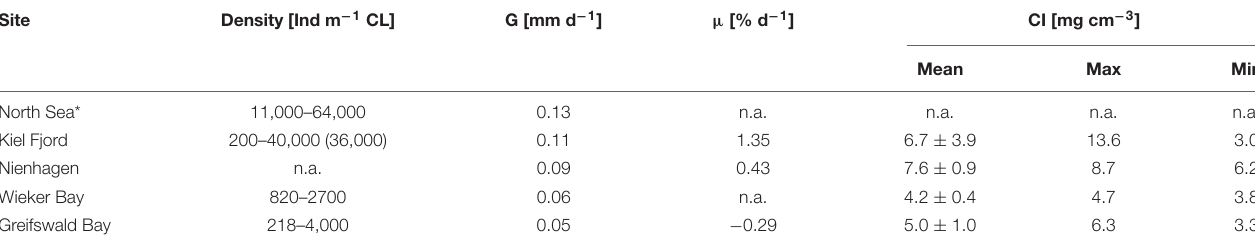
TABLE 3 | Settling density (individuals per meter of collector line, CL), shell growth rate (G), specific growth rate ( µ ), and mussel condition index (CI).